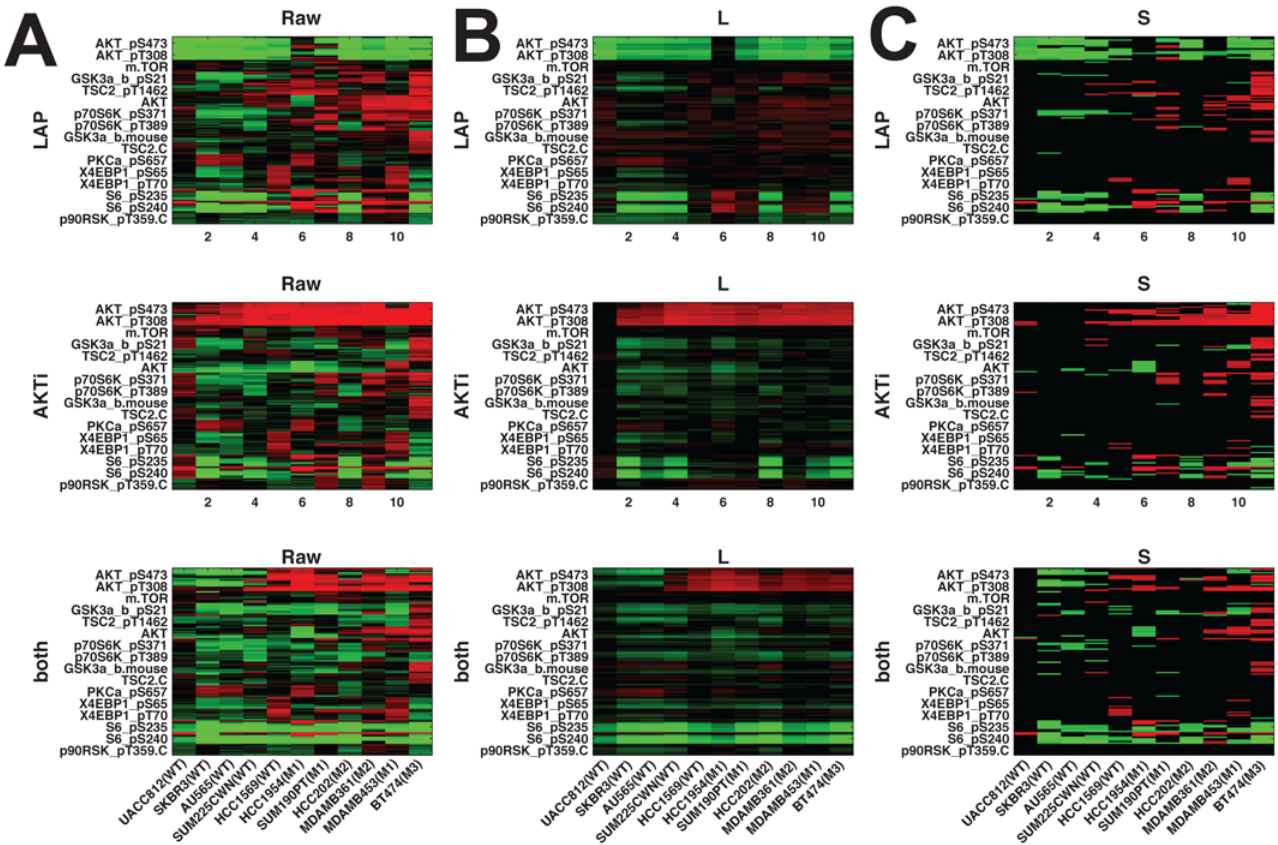
Fig 8. Application to RPPA data set. x-axis represents time steps ([0.5hr 1hr 2hr 4hr 8hr 72hr] for Raw data / Low-rank (L) / Sparse (S) respectively): ( A ) raw data X > ¼ ½ X > 1 ; X > 2 ;...; X > n (cid:5) 2 R n (cid:2) N T (cid:6) q ( B ) low-rank component L and ( C ) highly aberrant sparse component S using threshold ( WT : wild type, M1 : H1047R (kinase domain mutation), M2 : E545K (helical domain mutation), and M3 : K111N mutation in PIK3CA